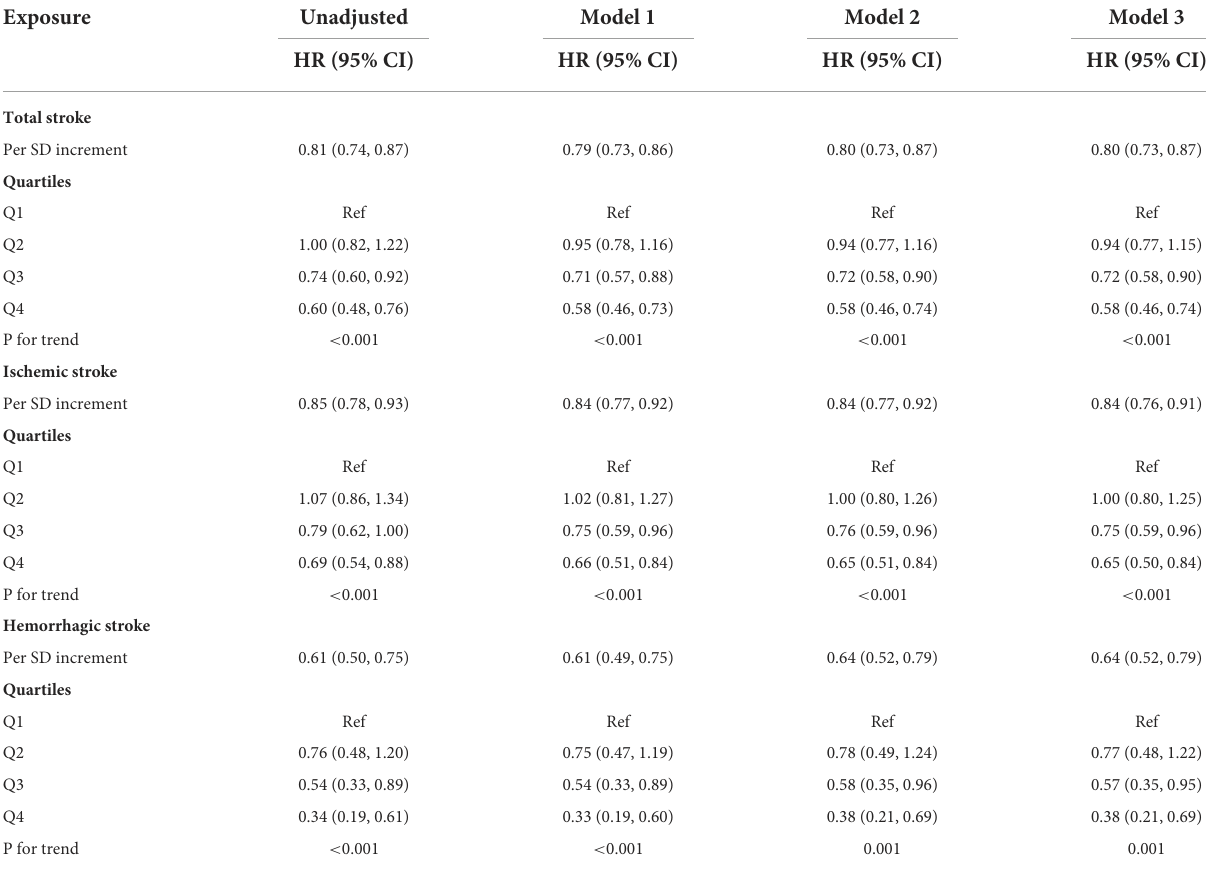
TABLE 2 Association between GNRI and the incidence of